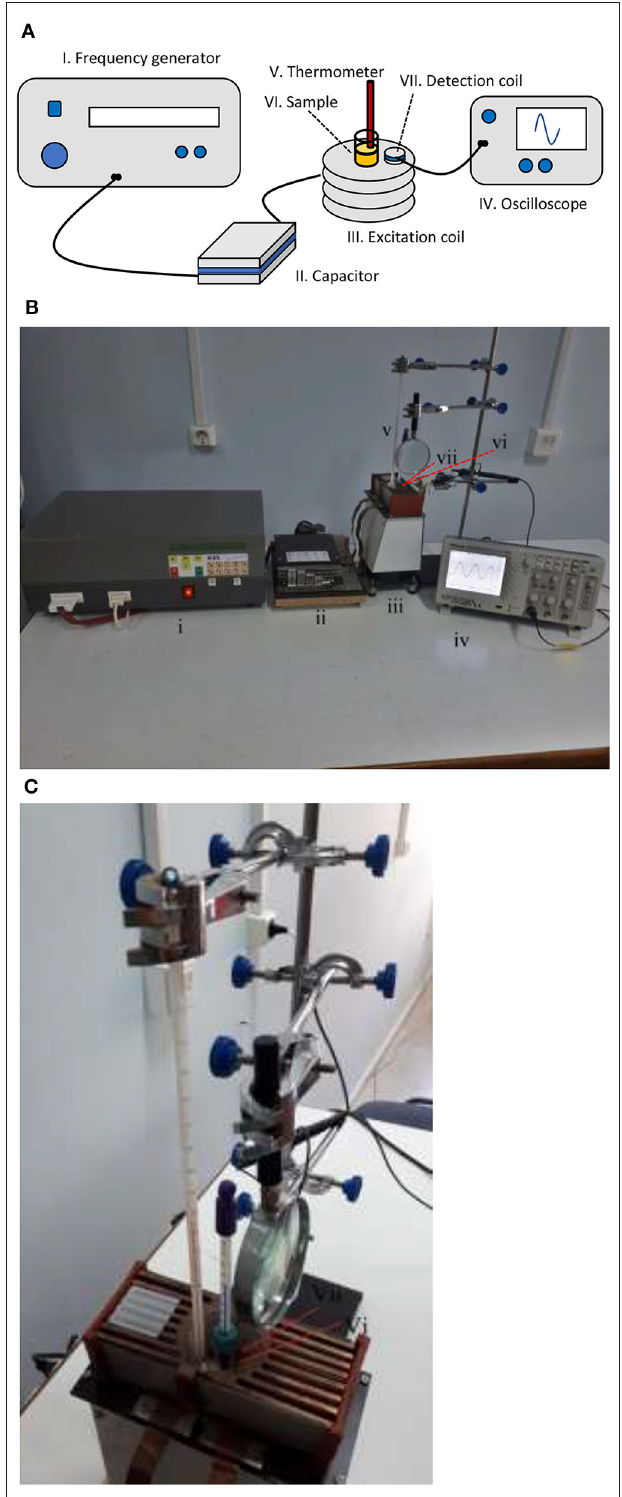
FIGURE 1 | Experimental setup. (A) Schematic and (B) photograph showing the whole setup and (C) photograph showing the sample surrounded by the detection coil and two